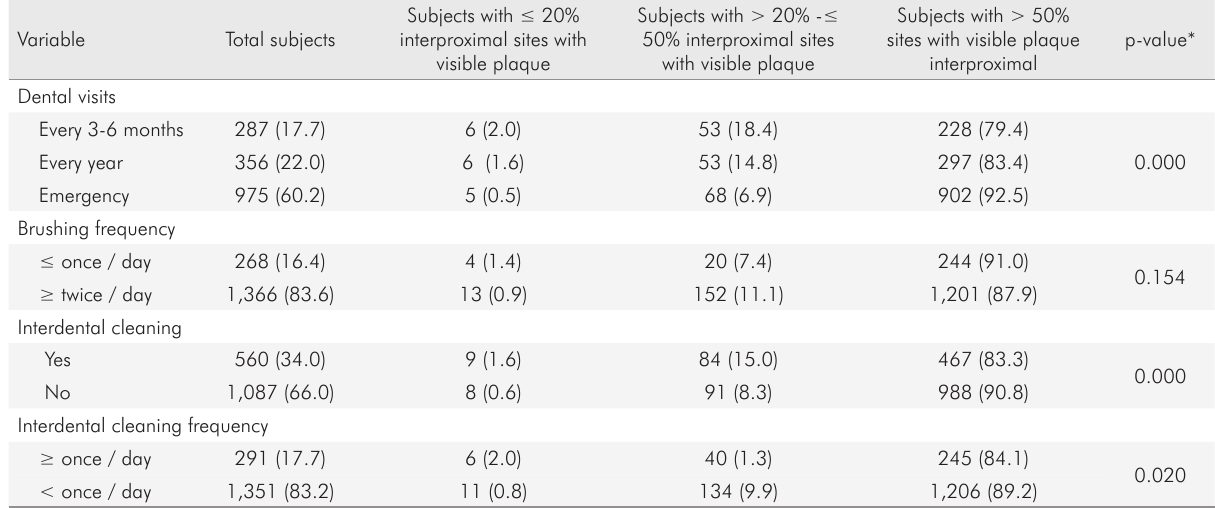
Table 4. Oral health behavior variables by prevalence of visible interproximal plaque: distribution of subjects (n and %) according to frequency of visible plaque